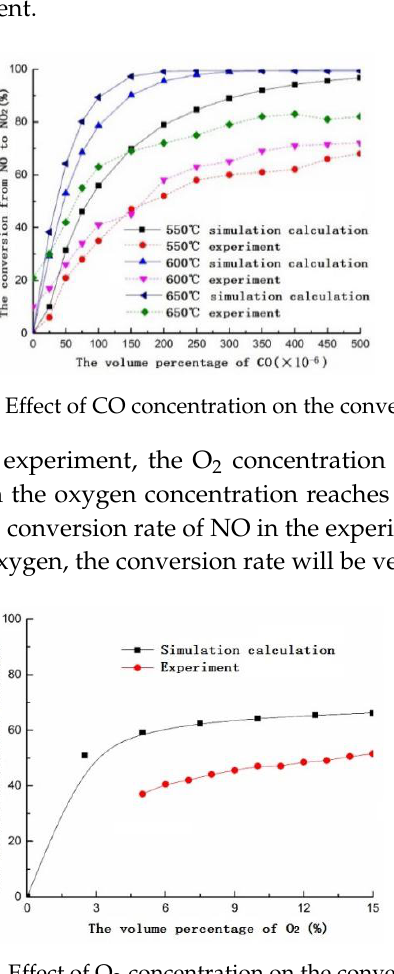
Figure 8. Effect of O 2 concentration on the conversion.